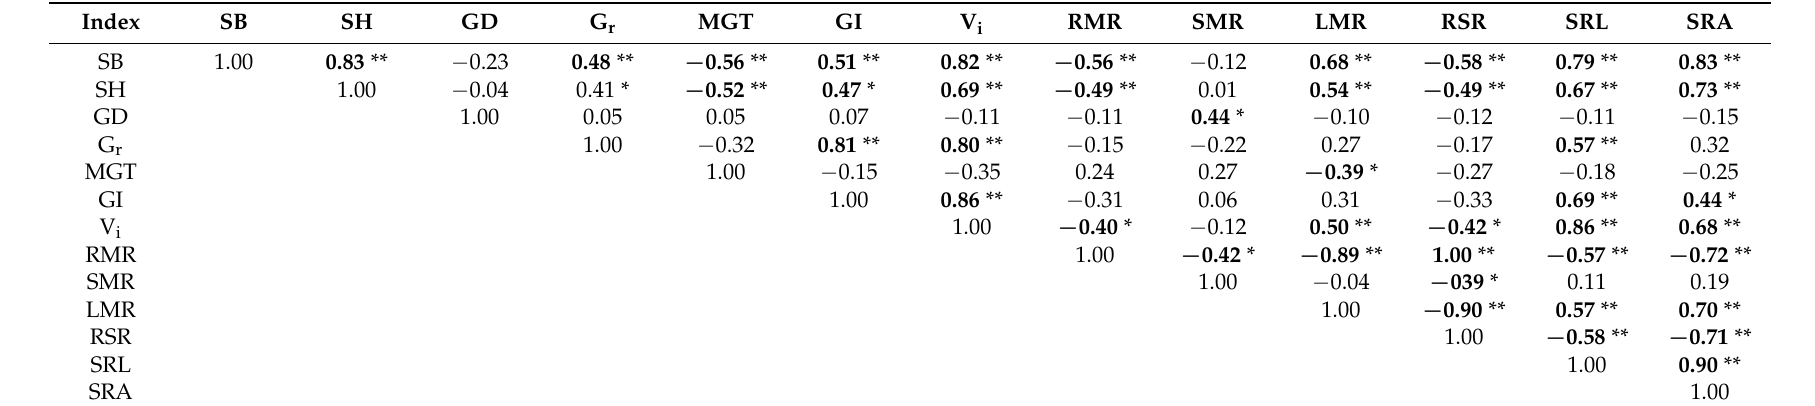
Table 2. Correlations among seed germination and seedling characteristics of Pinus thumbergii Parl. (Pearson correlation coefficient). SB: seedling biomass; SH; seedling; height; GD: ground diameter; G r : germination rate; MGT: mean germination time; G i : germination index; V i : vigor index; RMR: root mass ratio; SMR: stem mass ratio; LMR: leaf mass ratio; RSR: root/shoot ratio; SRL: specific root length; SRA: specific root